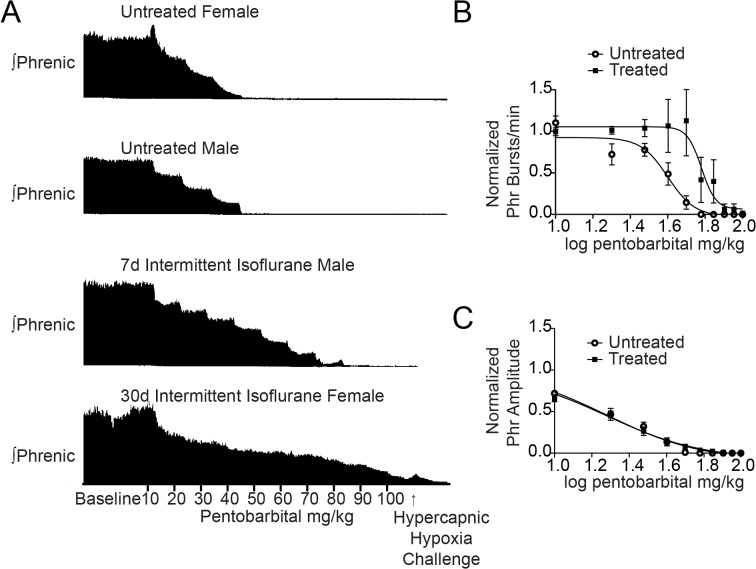
Phrenic nerve motor burst resistance to pentobarbital injections in isoflurane-treated rats.
A, Representative phrenic neurograms from an untreated female rat, untreated male rat, 7d isoflurane-treated male rat, and 30d isoflurane-treated female rat. After establishing baseline conditions, 10 mg/kg of pentobarbital was administered every 5 min up to a maximum total dose of 100 mg/kg. The protocol ended with 5 min of hypercapnic-hypoxia (PET CO2 = 80 mmHg, 13% inspired O2) to assess phrenic nerve response to maximal chemosensory input under 100 mg/kg of pentobarbital. The upper two panels show pentobarbital-mediated inhibition of phrenic nerve bursts in untreated female and male rats. The bottom two tracings demonstrate significant resistance of phrenic nerve bursts to pentobarbital in a 7d isoflurane-treated male rat and a 30d isoflurane-treated female rat. C, Pentobarbital IC50 curve of phrenic nerve burst frequency demonstrates a significant rightward shift after isoflurane treatment compared untreated rats. D, Pentobarbital IC50 curve of phrenic nerve amplitude demonstrates no change following isoflurane treatment.